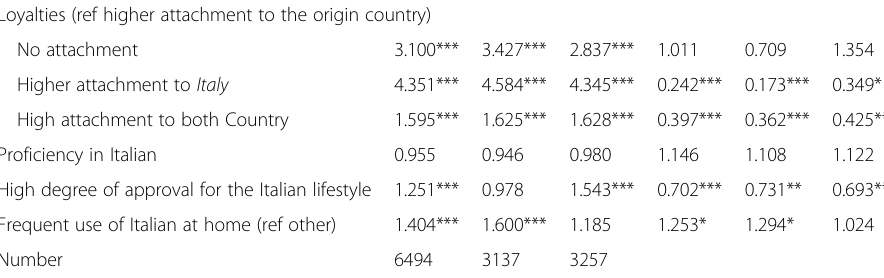
Table 3 Odds ratios and significance from the multinomial logistic regression models dependent variable length of stay (baseline ‘ for a long time ’ ) (Continued) Loyalties (ref higher attachment to the origin